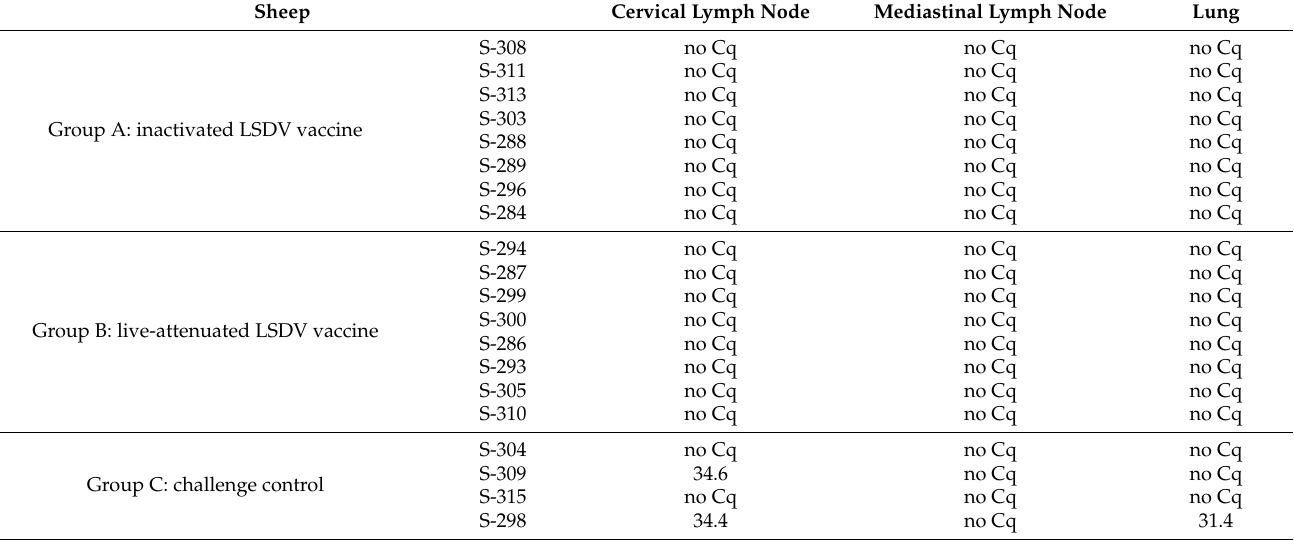
Table 1. Viral genome load in the organ samples taken during necropsy. Cq value of the real-time PCR are presented; no Cq = no virus genome could be